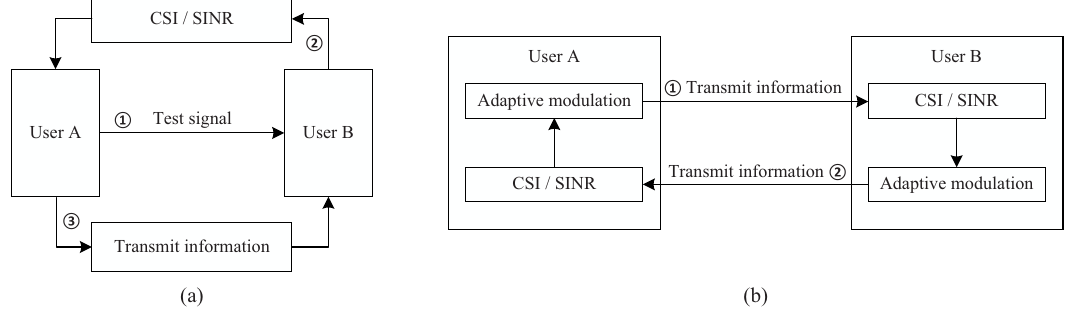
Figure 1. ( a ) Feedback adaptive communications; ( b ) direct adaptive